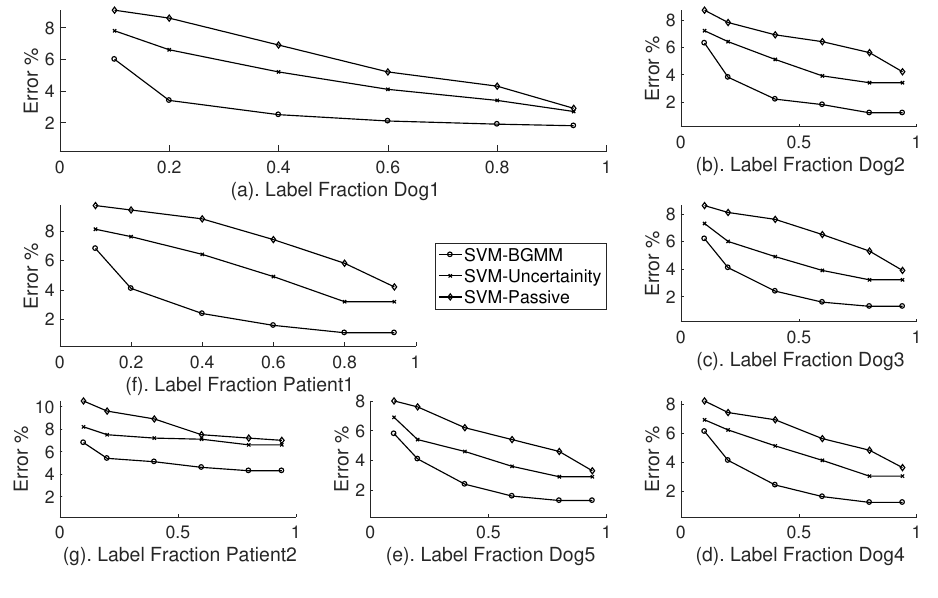
Figure 10. Label complexity of three different settings of the Support Vector Machine classifier. Error rate as a function of label